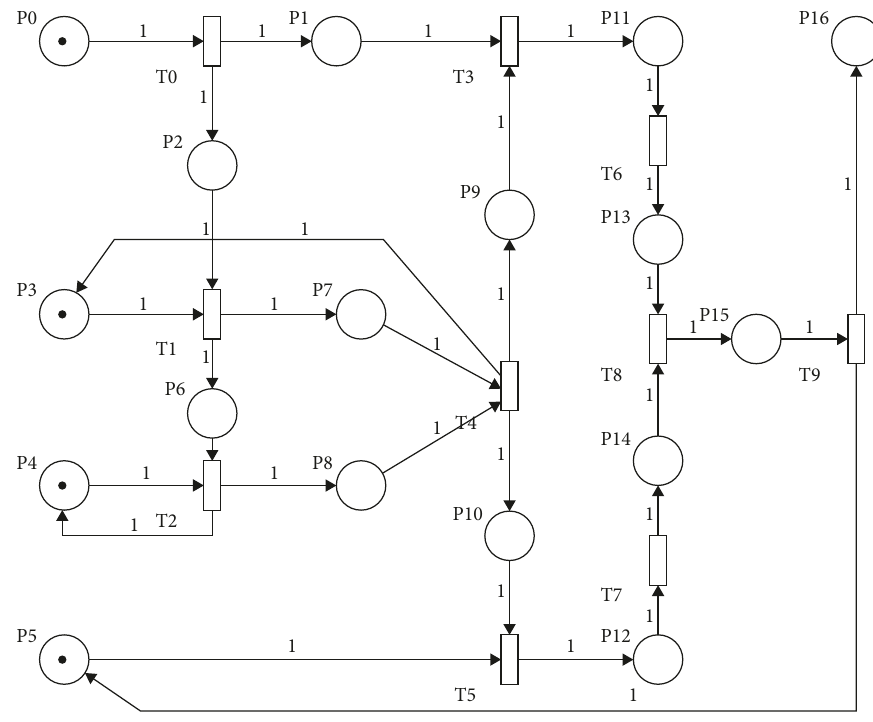
Figure 6: ERSCIED Petri net